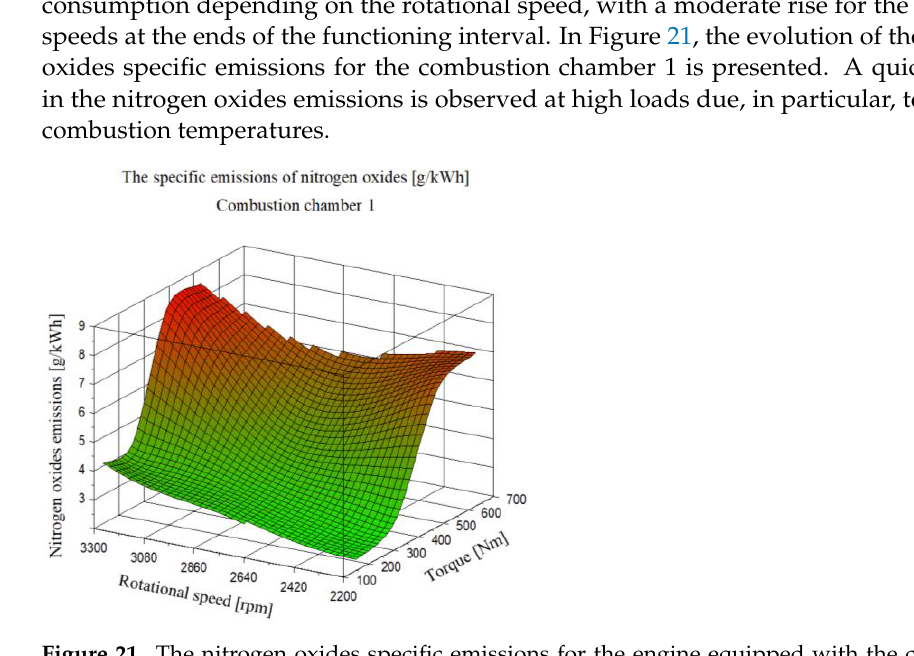
Figure 20. The specific fuel consumption of the engine equipped with the combustion chamber 1.